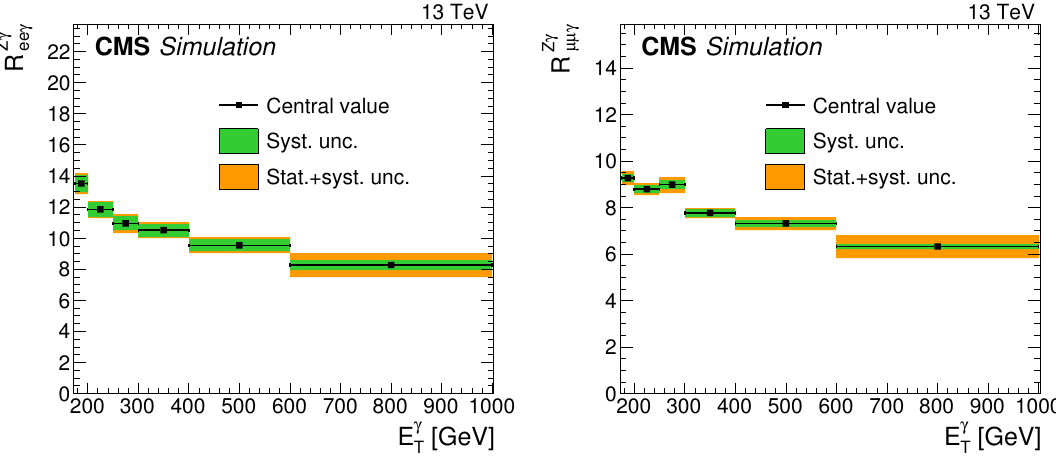
Figure 2 . Transfer factors R Z (cid:13) (left) and R Z (cid:13) (right). The uncertainty bands in green (inner) ee (cid:13) (cid:22)(cid:22)(cid:13) and orange (outer) show the systematic uncertainty, and the combination of systematic and statis- tical uncertainty arising from limited MC sample size, respectively. The systematic uncertainties considered are the uncertainties in the data-to-simulation correction factors (cid:26) for the lepton identi- (cid:12)cation e(cid:14)ciencies. Simulated Z( ! ‘‘ )+ (cid:13) events are generated in two samples, one with generated E (cid:13) required to be greater than 300 GeV, and one with a looser restriction. The E (cid:13) bin centred at T T 270 GeV is close to the boundary between the two samples, where there are fewer generated events. The relatively large statistical (cid:13)uctuation visible in the third bin of the right-hand (cid:12)gure results from